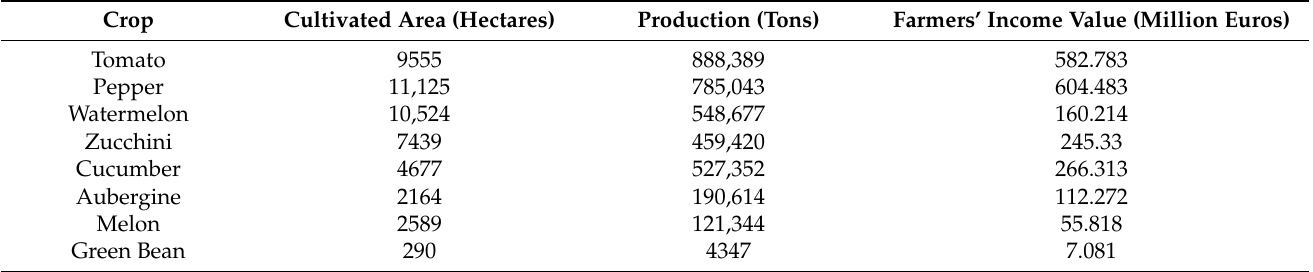
Table 1. Major aspects of greenhouse cultivation in the province of Almeria. Crop Cultivated Area